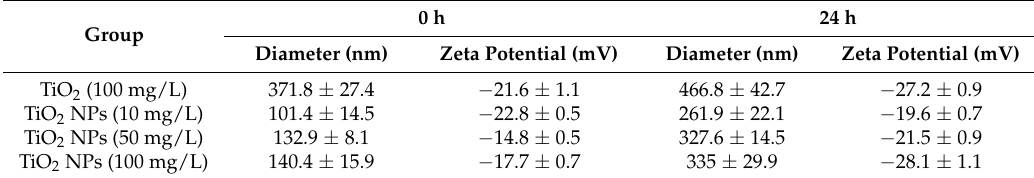
Table 2. Hydrodynamic size and Zeta potential of TiO 2 NPs in dispersion media.